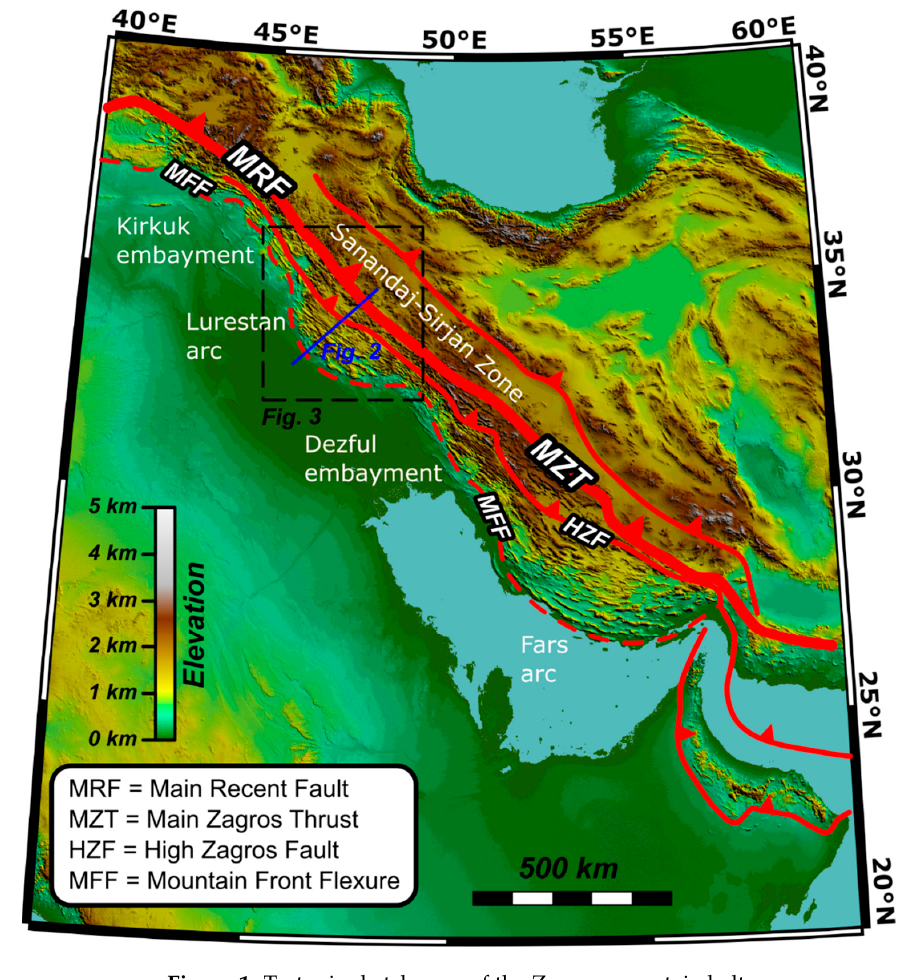
Figure 1. Tectonic sketch map of the Zagros mountain belt.